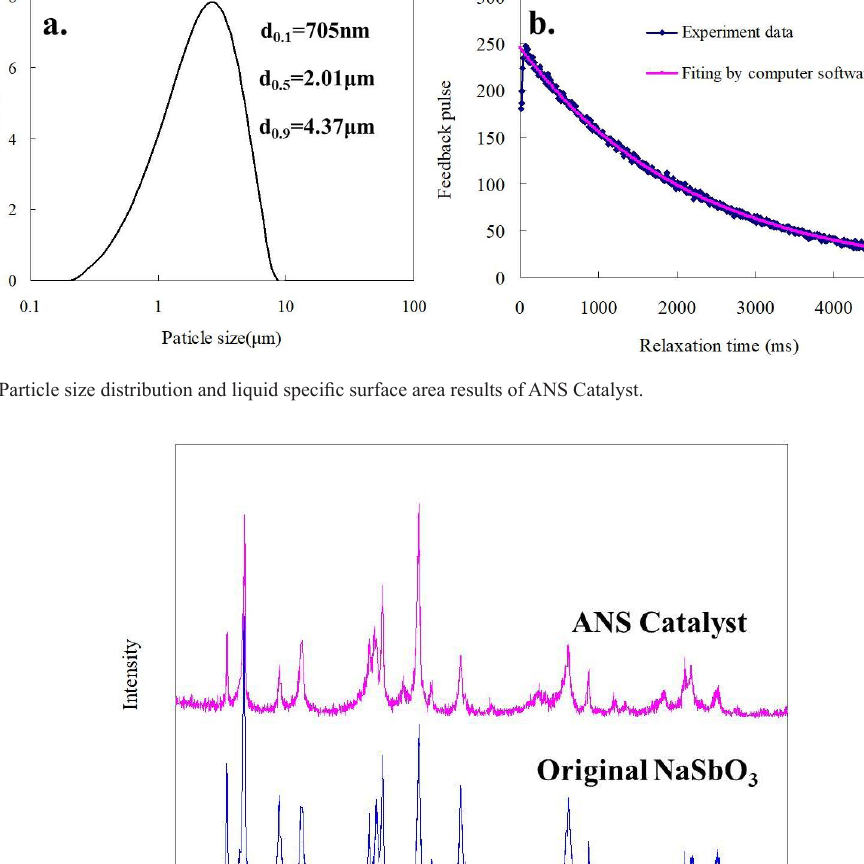
Figure 5. XRD patterns of original NaSbO